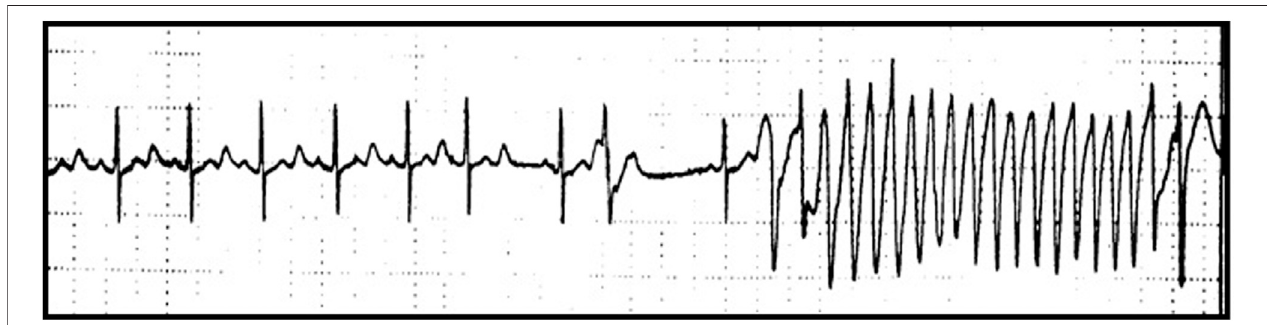
FIGURE 1 | QT prolongation and Torsade-de-pointes (TdP) following Quinidine therapy. Marked QT prolongation (corrected QT, QTc 520 ms) and Torsade-de- pointes (TdP) following Quinidine therapy (dosage quinidine polygalacturonate 275 mg b. i.d, equivalent to quinidine sulfate 200 mg b. id.) recorded during Holter monitoring in a female patient (age 62 years) with history of paroxysmal atrial fi